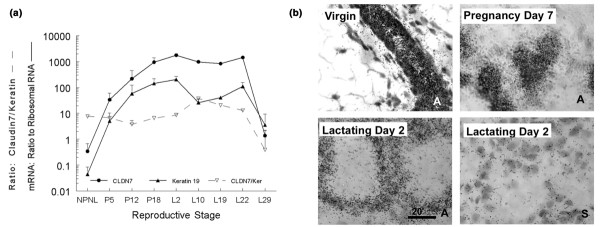
Developmental expression of claudin 7 mRNA in the murine mammary gland. (a) Real-time reverse transcriptase polymerase chain reaction measurement of claudin 7 and keratin 19 from total mammary glands of non-pregnant non-lactating (NPNL) mice, mice at 5, 12, and 18 days of pregnancy (P5, P12, and P18), and mice at 2, 10, 19, 22, and 29 days post partum (L2, L10, L19, L22, and L29). By L29 the pups have weaned themselves, and mammary gland involution is nearly complete. Dotted line, ratio of claudin 7 RNA to keratin 19 at the same time points. Three mice analyzed at each time point. Error bars represent SEM. Where no bar is visible, the SEM falls within the symbol. Asterisks indicate points that differ significantly from values at L2, P < 0.05. (b) In situ hybridization of claudin 7 probes to sections from virgin, pregnant, and lactating mammary glands. Sections labeled A were hybridized to the anti-sense probe; the lower right-hand section labeled S is the sense control. Scale bar, 20 μm.